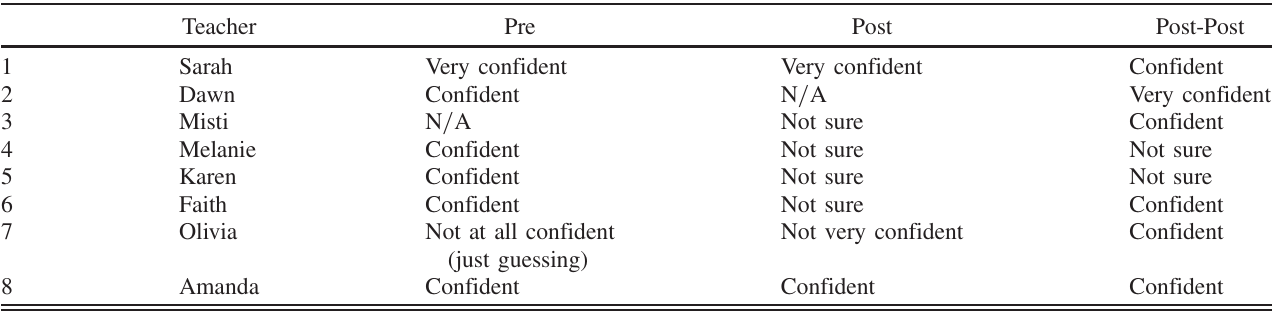
TABLE VI. Teacher confidence on LPCI. Note that teacher responses to LPCI question asking “ In general, how confident are you that your answers to this survey are correct?